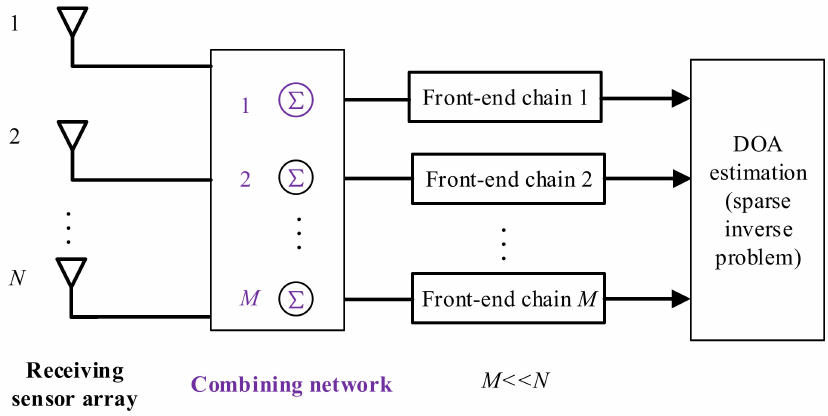
Figure 5. A general framework of a spatial CS for DOA